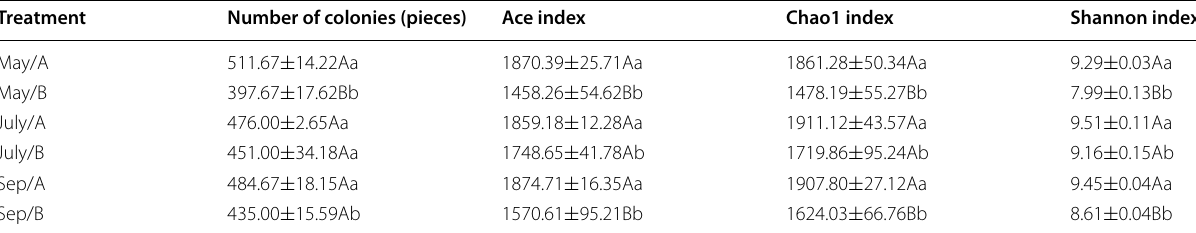
Table 1 Quantity and diversity index of the bacterial community in the soil in sweet potato intercropping and monoculture in a banana orchard